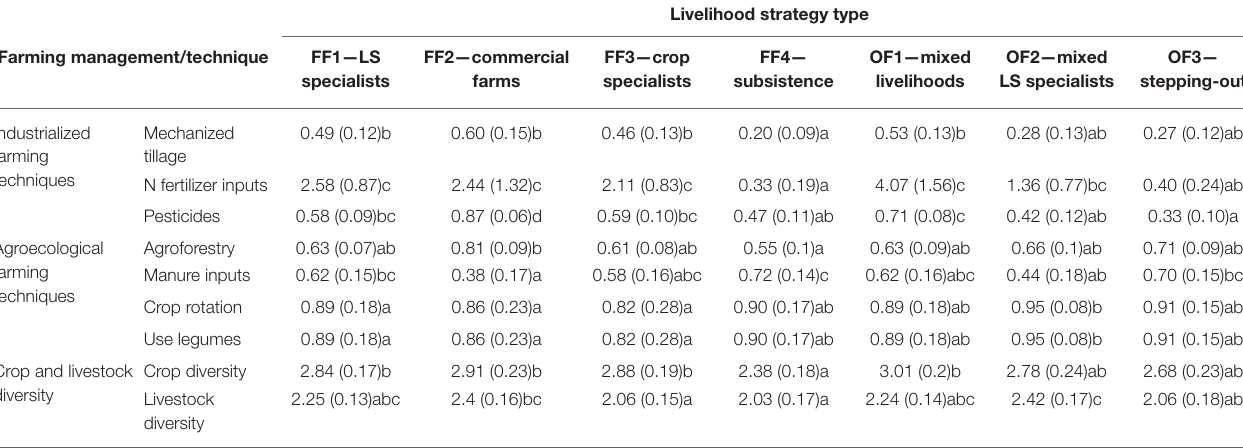
TABLE 6 | Estimated marginal means for farm management practices of the different household livelihood strategy types #